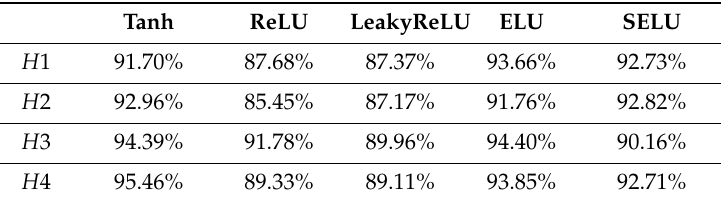
Table 4. The AUC results of the Adam optimizer.